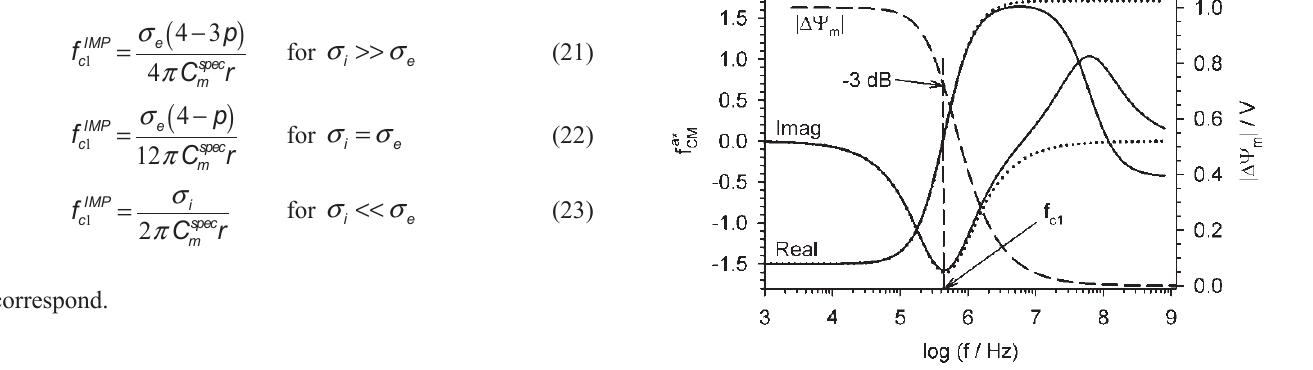
Fig. 9: Real and imaginary parts of the Clausius-Mossotti factor (full lines, left ordinate) as well as the induced transmembrane potential (dashed line, right ordinate) at the pole of a spherical cell model (Table 1). Dotted lines: spectra are reduced to the membrane dispersion when the permittivities of the bulk media are neglected. Vertical dashed line: -3 dB frequency of the absolute value of the induced transmembrane